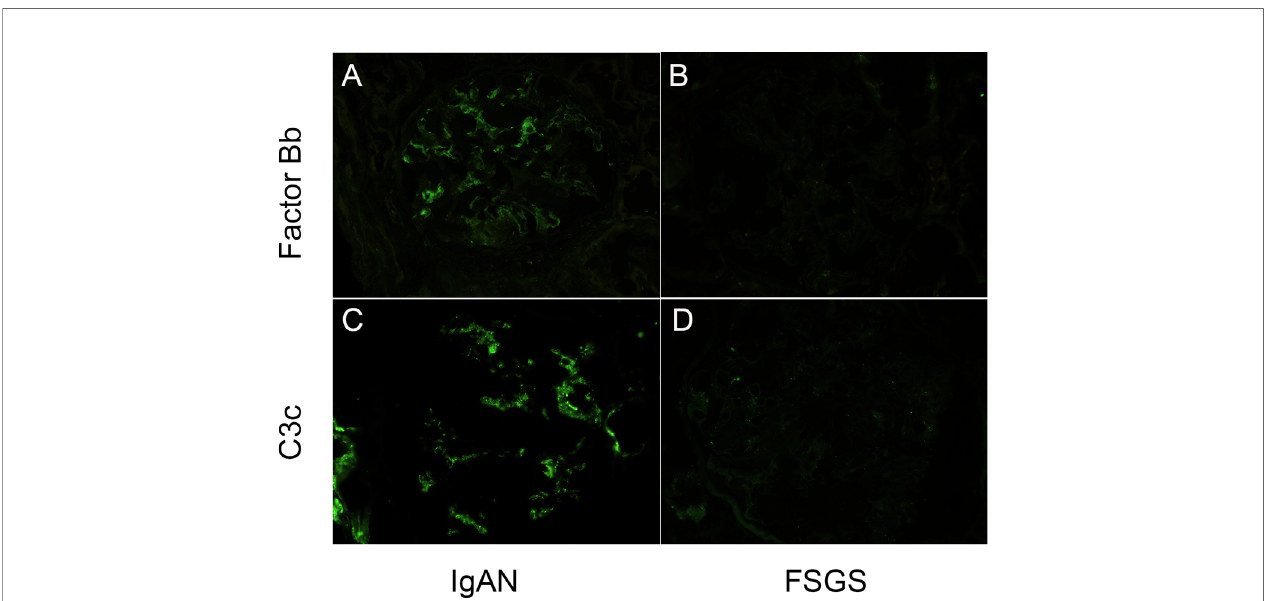
FIGURE 3 | Glomerular complement factor Bb and C3c deposits were detected in IgAN patients. (A, B) Mesangial positivity can be seen in the complement factor Bb and C3c stains on the glomerulus of a patients with IgA nephropathy. (C, D) No intensity can be detected in the complement factor Bb and C3c stains on the glomerulus of a patient with focal segmental sclerosis. (Magni fi cation: